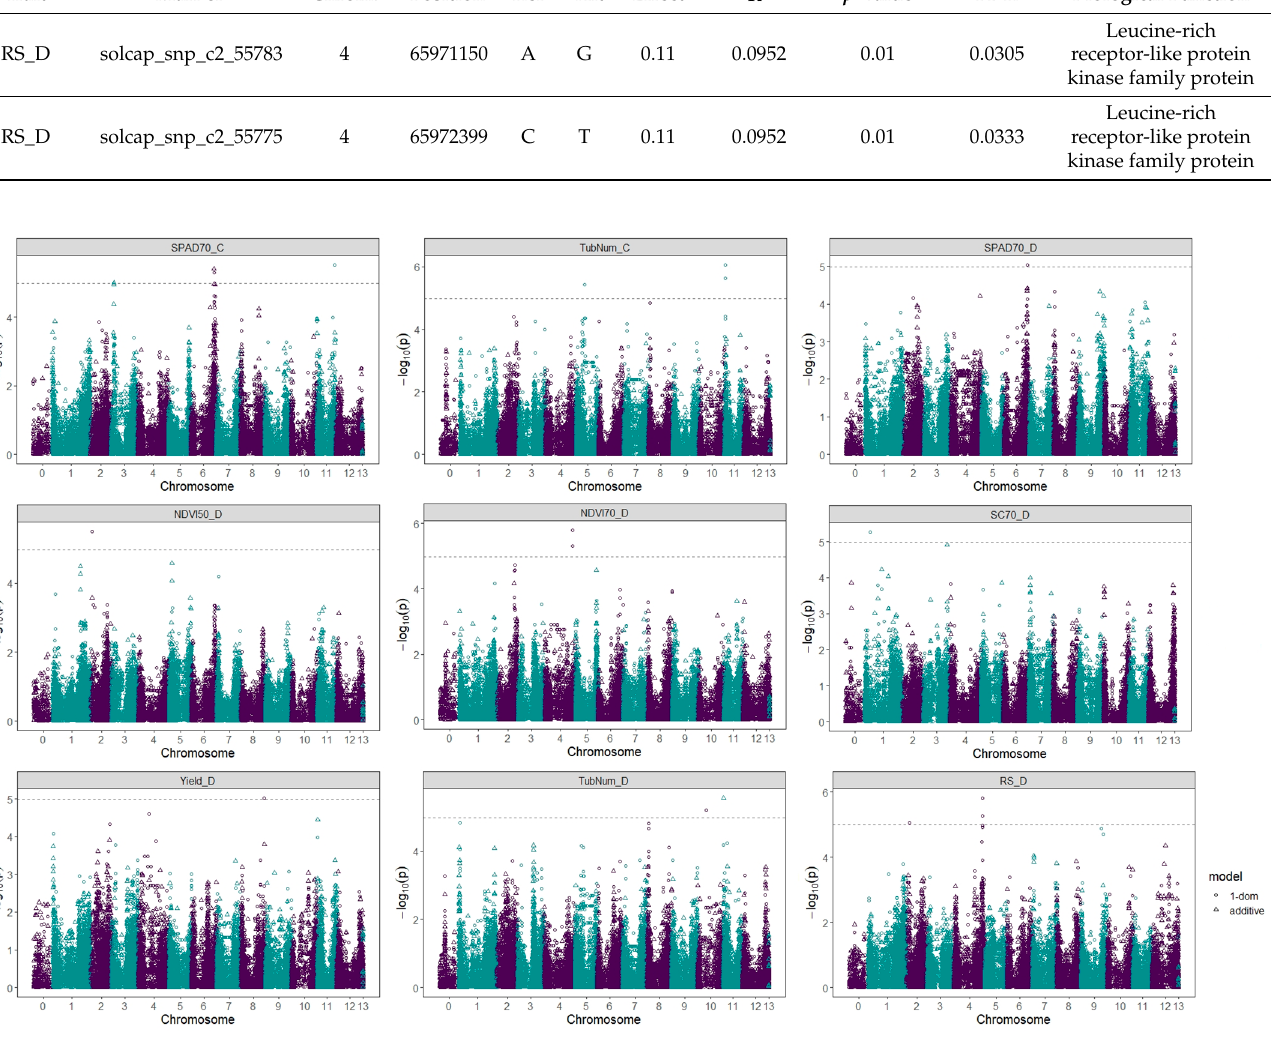
Figure 2. Manhattan plots for the traits with significant SNPs associated under control and drought stress conditions in 144 potato varieties. stress conditions in 144 potato